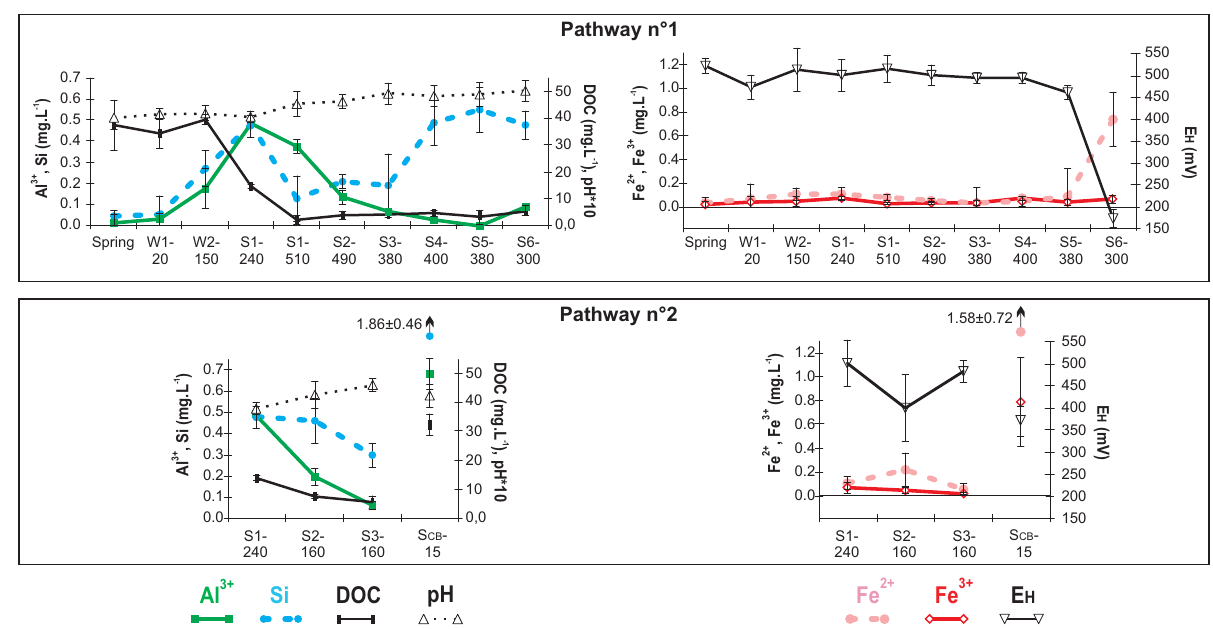
Fig. 5. Average composition of the sampled waters along the pathways No. 1 and No. 2. Vertical bars give the calculated standard deviation for each set of